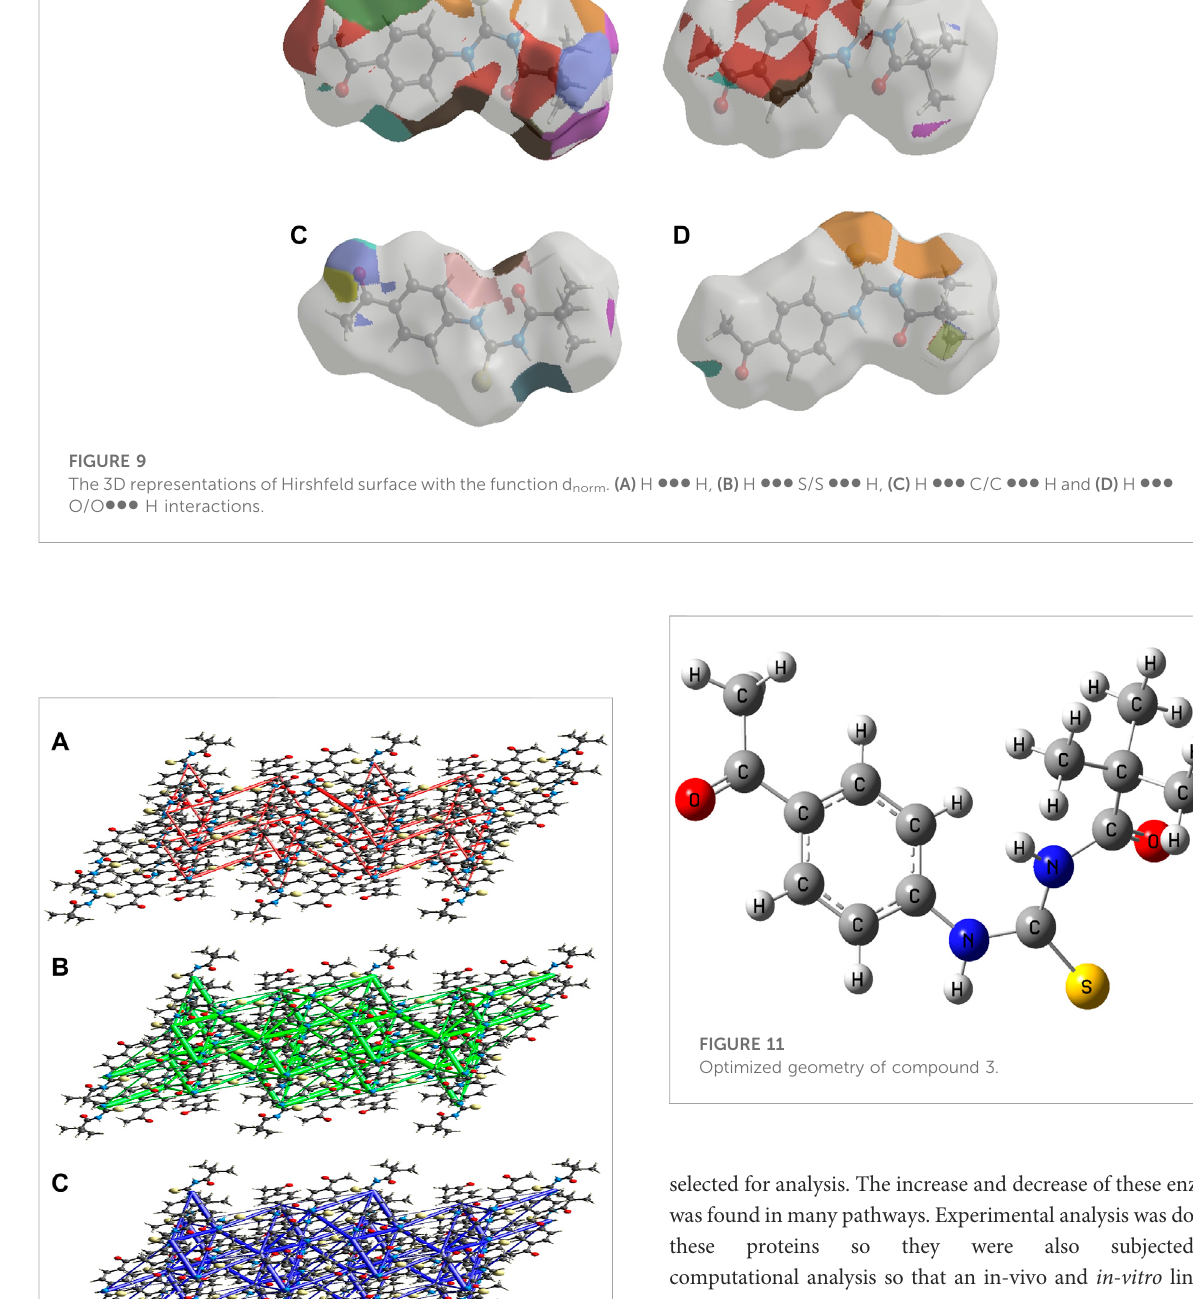
FIGURE 10 Perspective views of the energy frameworks for a cluster of the title compound molecules showing different energy forms i.e., (A) electrostatic energy, (B) dispersion energy and (C) total energy diagrams.